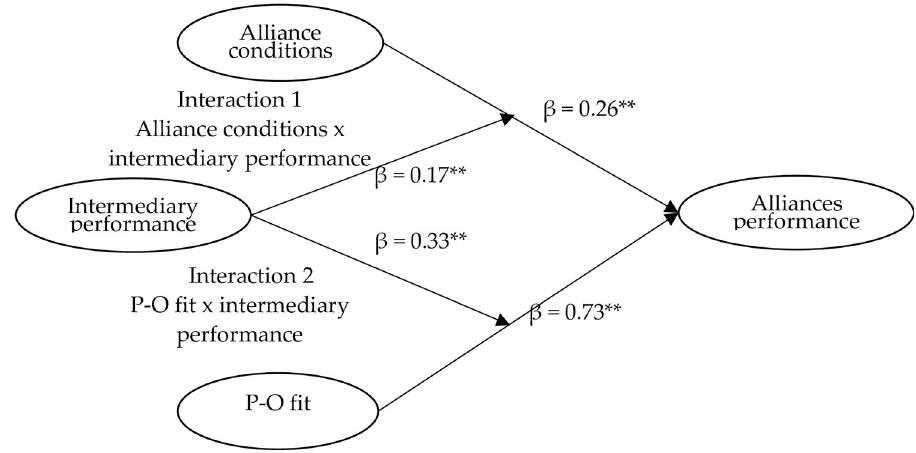
Fig 4. The moderated structural equation model diagram. �� p <